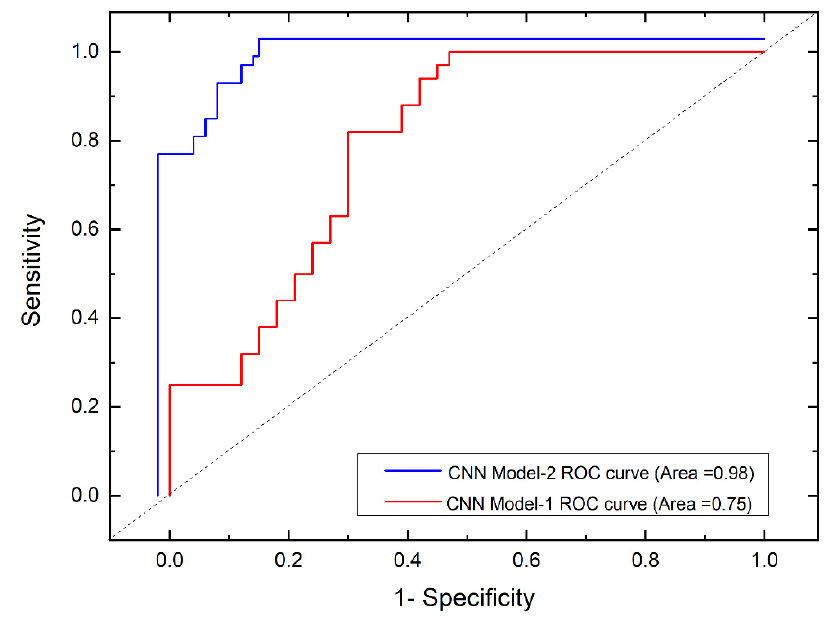
Figure 4. ROC curves of the proposed behavior detection models.